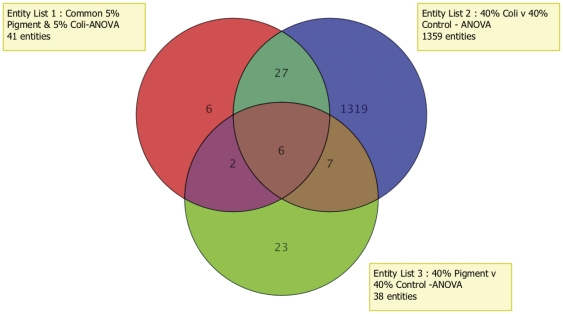
Venn diagram indicating the overlap between genes with differential expression in human TM cells phagocytically challenged with E. coli and pigment under physiological and oxidative stress conditions.